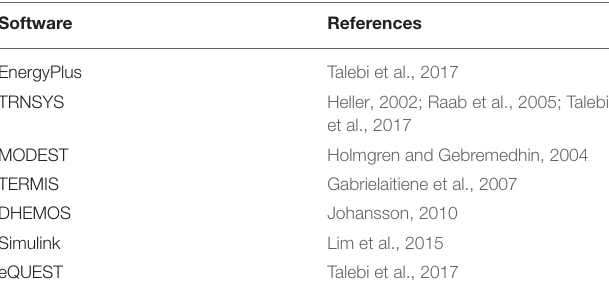
TABLE 1 | Simulation software used in the modeling of district